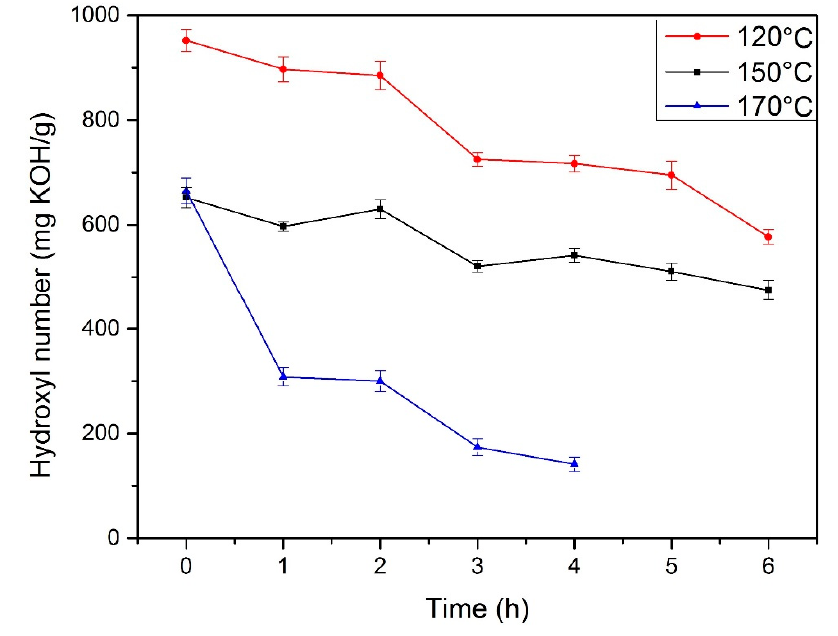
Figure 2. Change of hydroxyl number of obtained polyols.